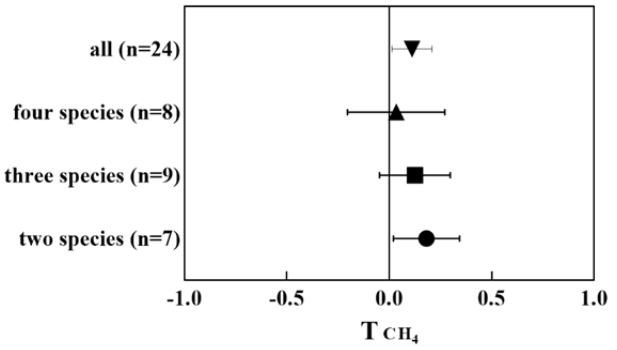
Figure 5. Effect on T index of CH 4 emission from monoculture CWs compared to polyculture CWs (two, three, and four species).